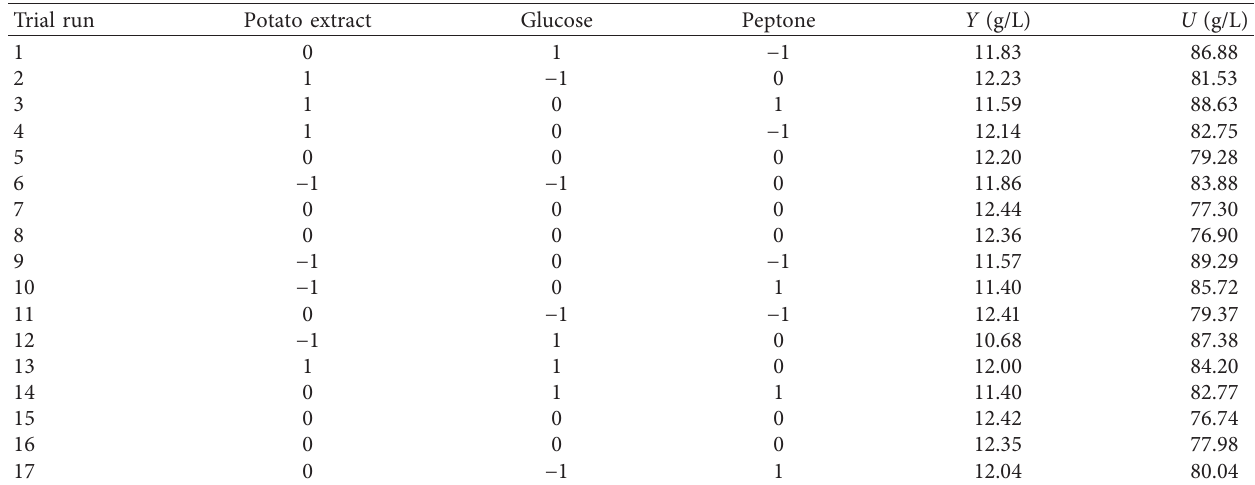
Table 7: Experimental design and results of Box–Behnken.